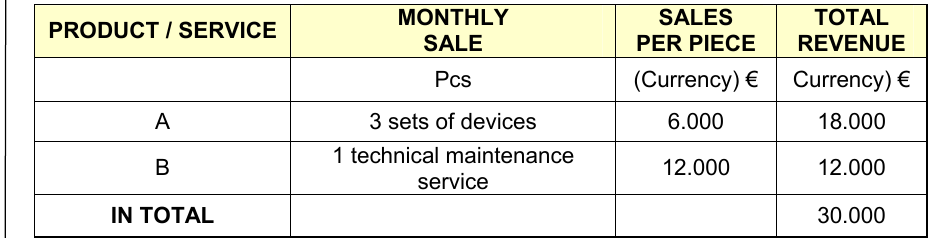
Table 2 – Projected revenues in the twelfth month Таблица 2 – Прогнозируемые доходы в XII месяце Табела 2 – Пројекција прихода у XII месецу